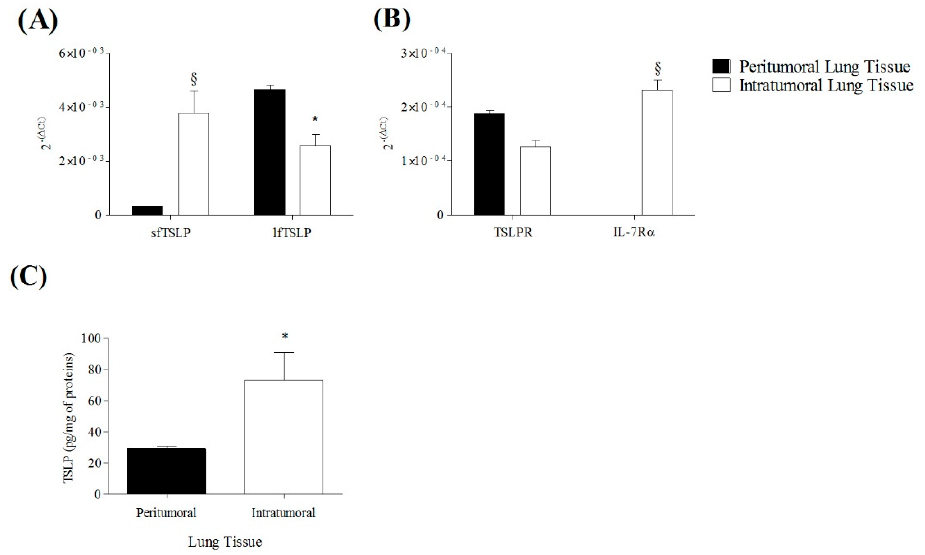
Figure 8. Expression of sfTSLP, lfTSLP, TSLPR, and IL-7R α mRNAs in peritumoral and intratumoral human lung tissues. Peritumoral and intratumoral human lung tissues (2 mg) disrupted by homoge- nization were lysed and 500 µ L of 0.1% Triton X-100. sfTSLP and lfTSLP mRNAs were determined by quantitative RT-PCR ( A , B ). Total TSLP was evaluated in lysed peritumoral and intratumoral lung cancer tissue by ELISA ( C ). Data are mean ± SD of 5 independent experiments obtained from different patients. * p < 0.01 and § p < 0.0001 vs. peritumoral lung tissue.